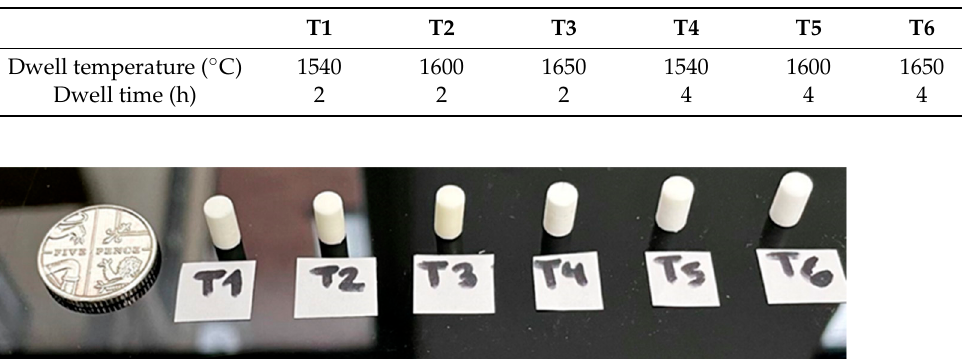
Figure 1. Digital Light Processed green sample.